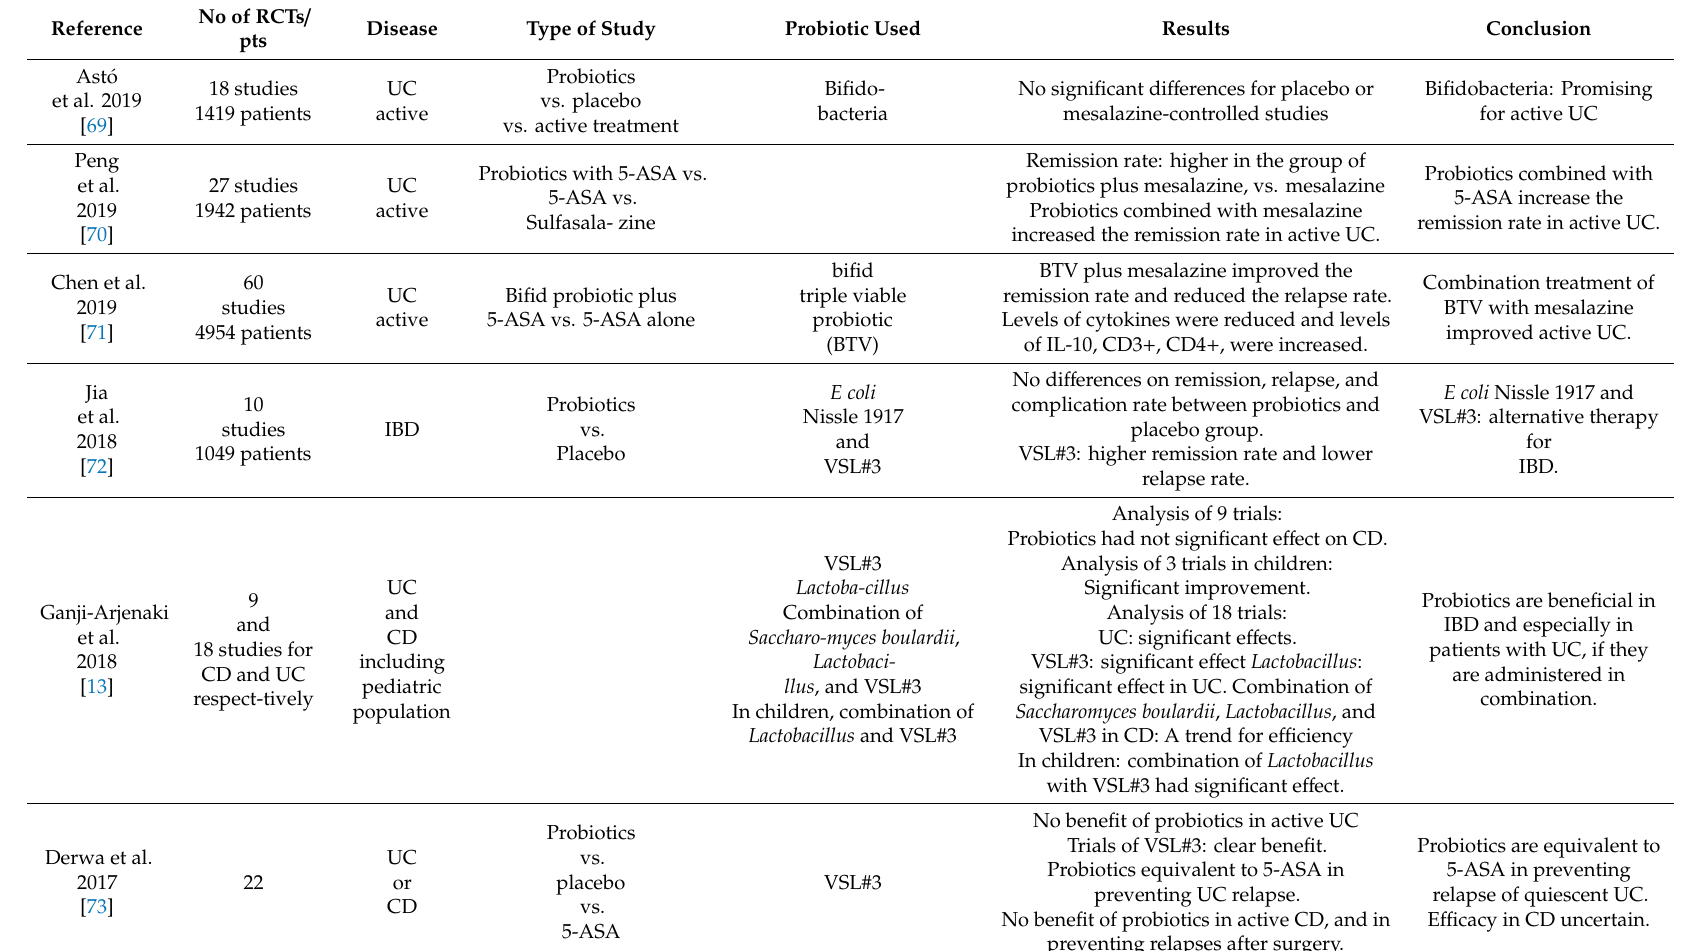
Table 4. Systematic reviews and metaanalyses concerning the role of probiotics in